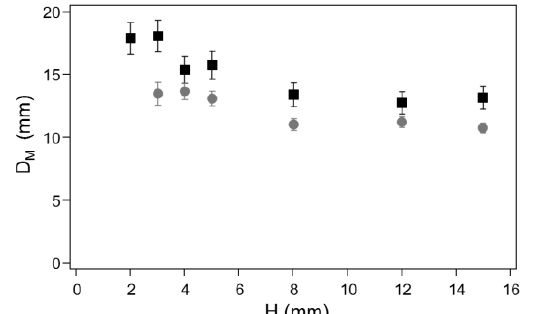
Fig. 5. D M value of hydrogels reached at asymptotic time as a function of cell aperture H. ■ individual growth experi ments , ● collective growth experiments. The bars represent the standard deviation with respect to the mean value measured experimentally.